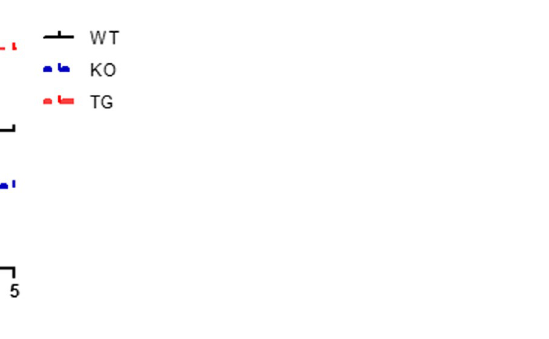
Figure 4. Over expression of GDF15 prevents LPS-induced mortality of animals. WT, TG and KO mice (n = 8) were i.p . injected with 20 mg/kg LPS. Animal health and survival was observed every 12 h in for 5 days after LPS